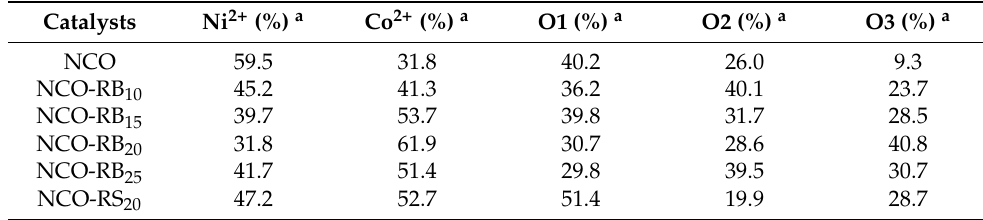
Table 2. The XPS parameters of NCO and NCO-R.